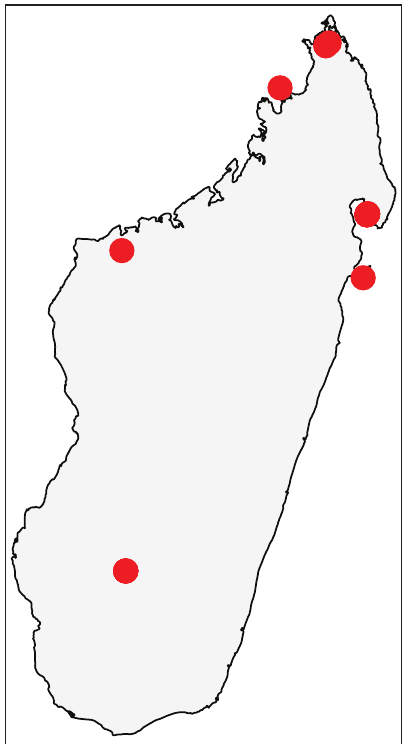
Figure 17. Geographic distribution of Nesomyrmex brunneus sp. n.. The known localities of N. brunneus sp. n. shown in Madagascar.